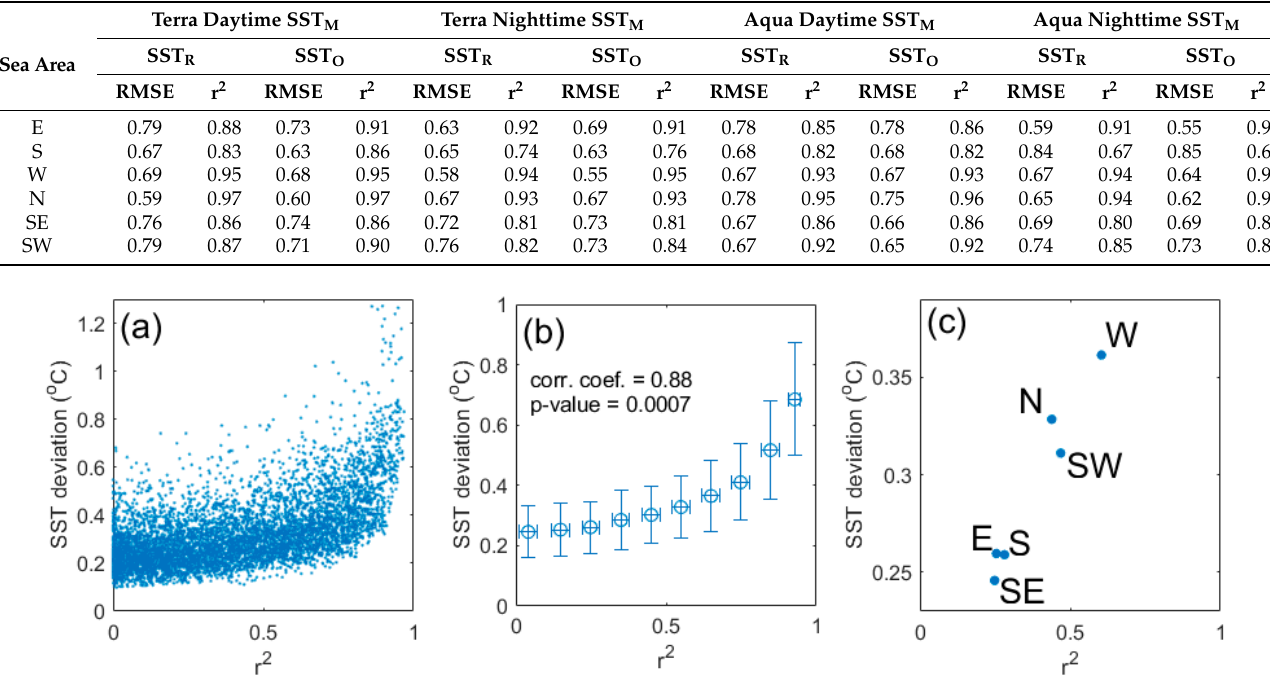
Table 3. Statistical results between SST M and SST R /SST O .